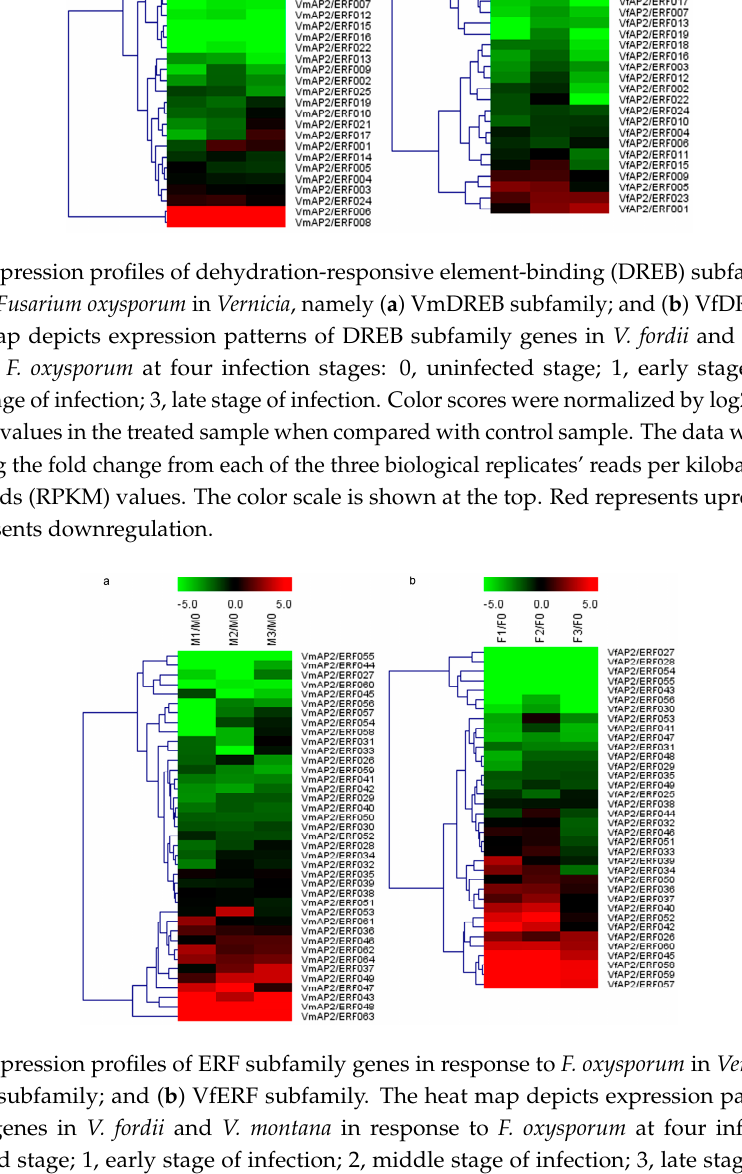
Figure 4. Expression profiles of ERF subfamily genes in response to F. oxysporum in Vernicia , namely ( a ) VmERF subfamily; and ( b ) VfERF subfamily. The heat map depicts expression patterns of ERF subfamily genes in V. fordii and V. montana in response to F. oxysporum at four infection stages: 0, uninfected stage; 1, early stage of infection; 2, middle stage of infection; 3, late stage of infection. The heat map was generated based on the transformed counts of log2-transformed fold change values in the infected sample compared with the control. The color scale is shown at the top. Red represents upregulation and green represents